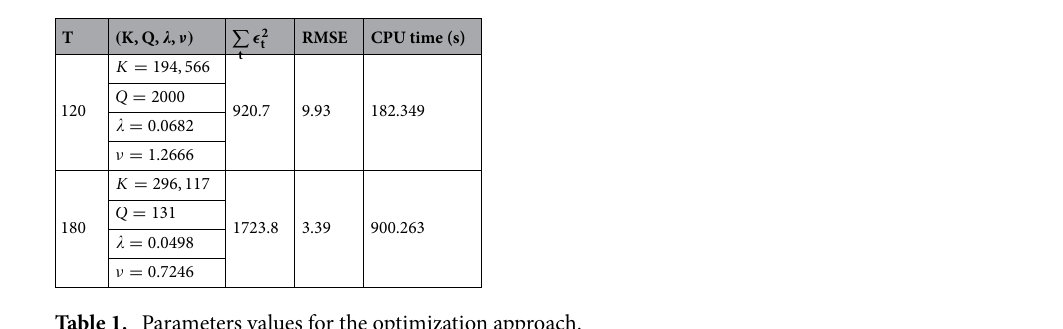
Table 1. Parameters values for the optimization approach.